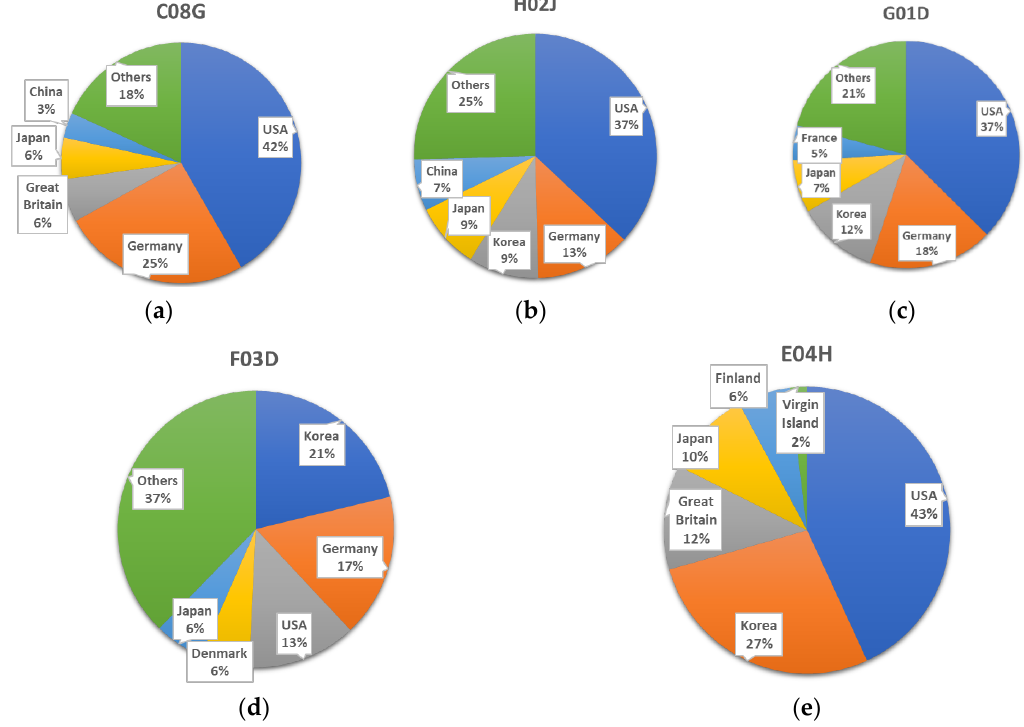
Figure 8. Top five countries in terms of numbers of patents registered. ( a ) Chemistry cluster; ( b ) Electrical engineering cluster; ( c ) Instrument cluster; ( d ) Mechanical engineering cluster; ( e ) Other Fields cluster.